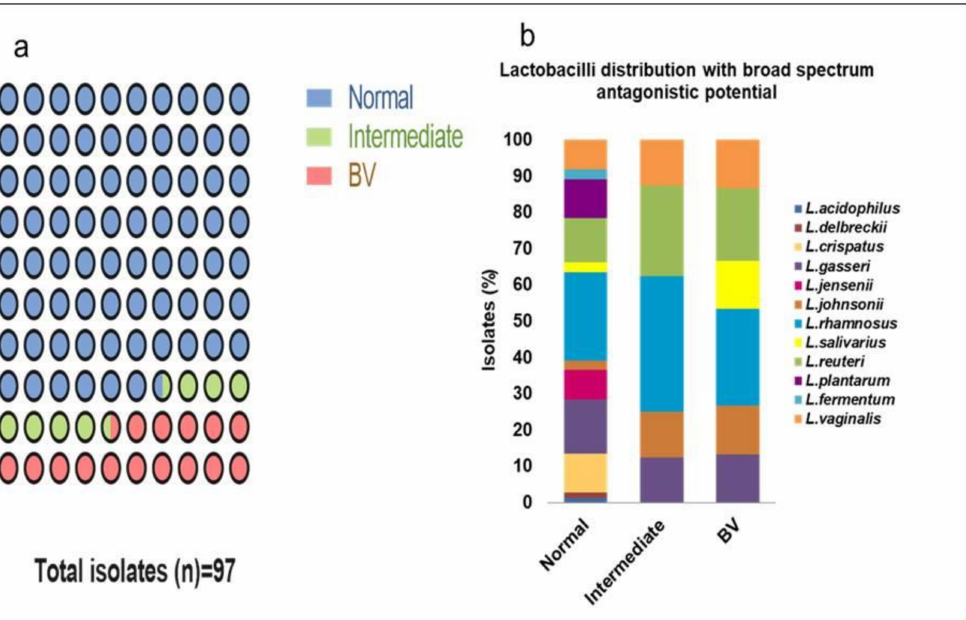
Figure 7. Lactobacilli with broad-spectrum antimicrobial activity. Lactobacilli isolates showing ≥ 90% growth inhibition on all the tested urogenital pathogens. ( a ) Proportions of lactobacilli isolates from normal, intermediate, and BV microbiota. The parts of the whole plot indicate that 76.29%, 8.25%, 15.46% of the isolates with broad-spectrum antimicrobial activity belonged to normal, intermediate and BV microbiota, respectively. ( b ) Lactobacillus species distribution from each normal, intermediate, and BV microbiota. The stack bar graph indicates the diversity of lactobacilli with broad-spectrum antimicrobial potential in normal microbiota is di ff erent from intermediate and BV